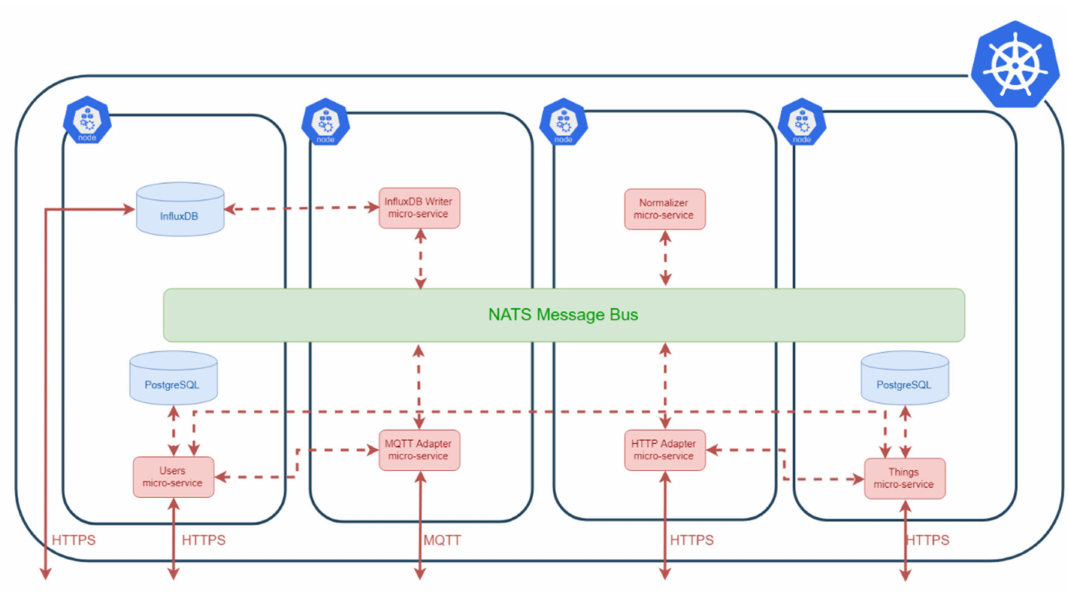
Figure A3. Mainflux microservice